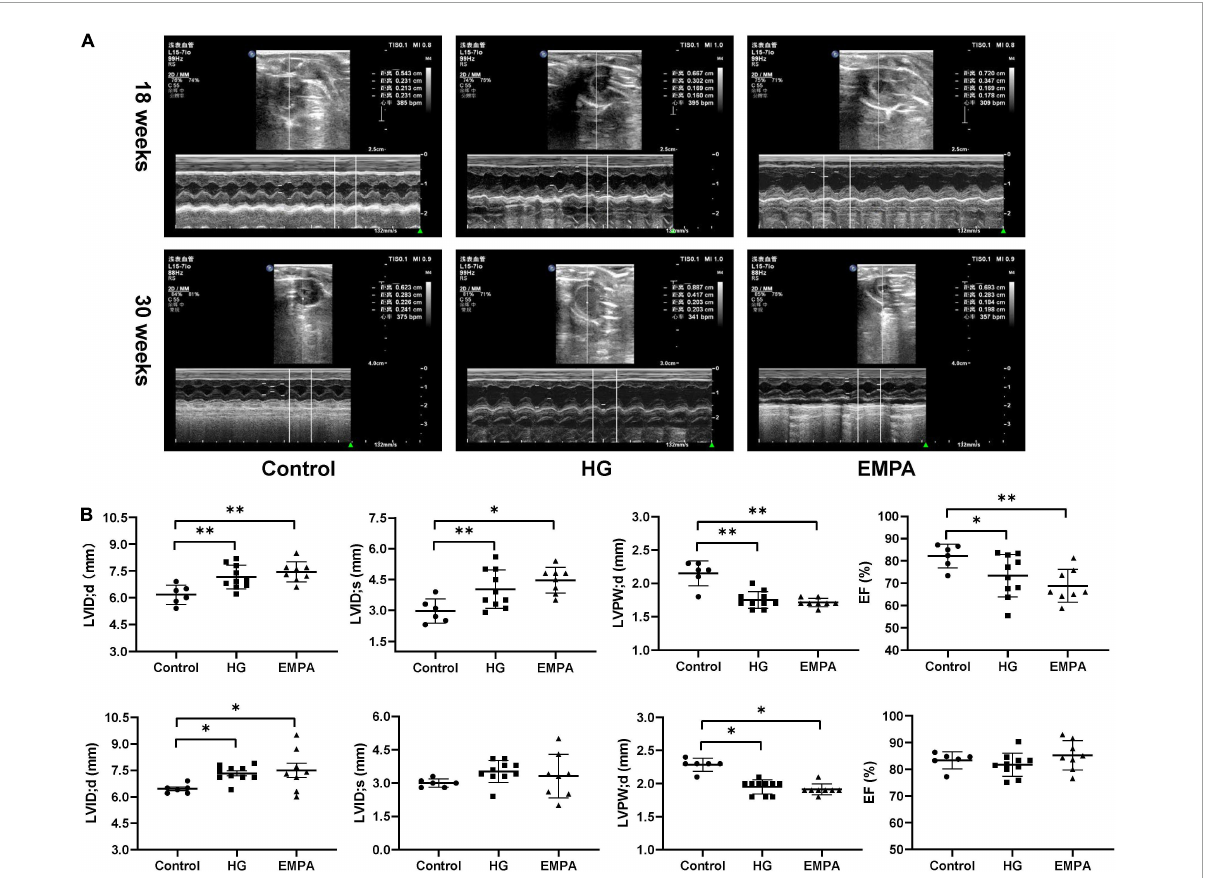
FIGURE2 In three groups, echocardiographic measurements of the rats at 18 weeks and 30 weeks after STZ injection. (A) Representative M-mode tracings of rats in three groups ( n = 6 for the control group, n = 10 for the high glucose (HG) group, and n = 8 for the empagliflozin (EMPA) group). (B) Plots of echocardiographic measurement results for left ventricle internal dimension at end-diastole/systole (LVID;d/s), left ventricle posterior wall thickness at end-diastole (LVPW’d), and ejection fraction (EF) percentage, upper part for 18 weeks, the lower part for 30 weeks. ∗ p < 0.05, ∗∗ p <